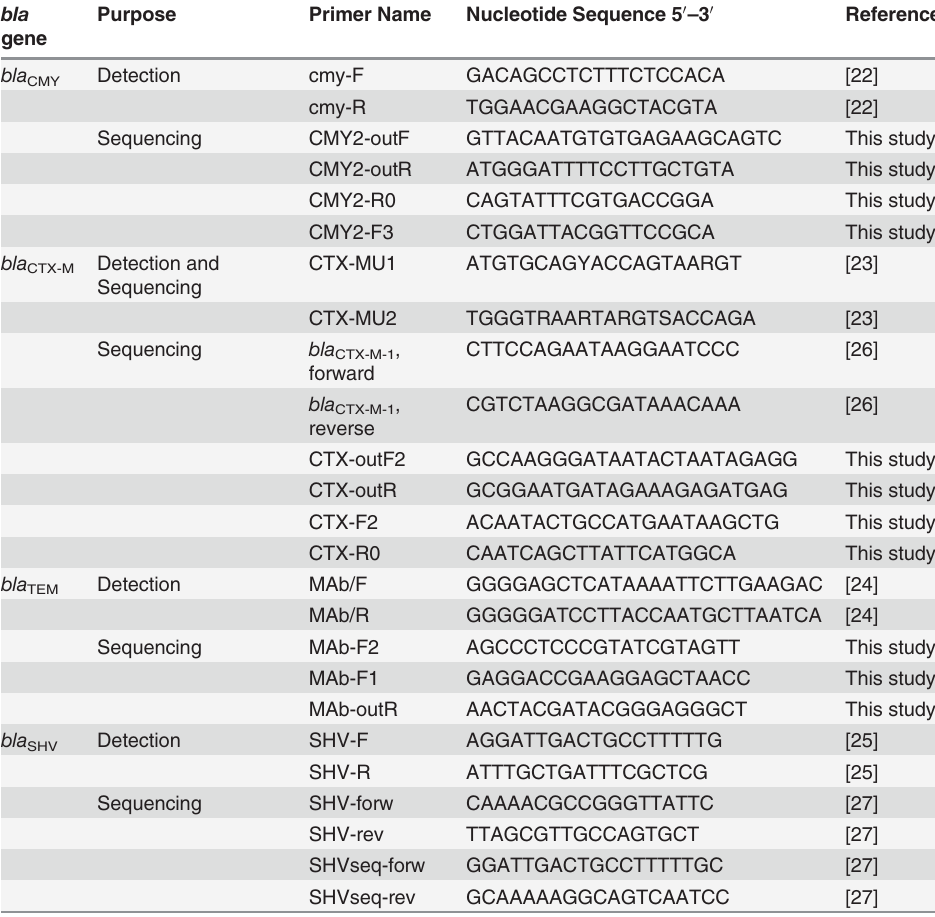
Table 2. Sequences of primers used in this